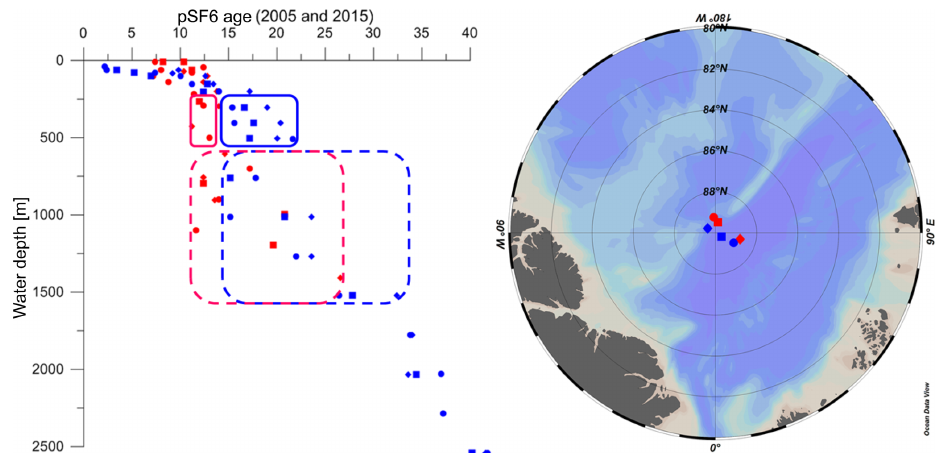
Figure 4. Comparison of pCFC and pSF 6 (partial pressures of CFC and SF6, respectively) ages from 2005 (red) and 2015 (blue) in the Amundsen Basin at stations located in the return flow along the Lomonosov Ridge, distinguishing the depth ranges of FSBW (solid box) and BSBW (dashed box). Locations of 2015 stations are marked in the map as blue symbols (81: dots; 85: squares; 89: diamonds) and 2005 stations in red (41: dots; 42: squares; 46: diamonds). Copyright: Schlitzer, R., Ocean Data View, odv.awi.de